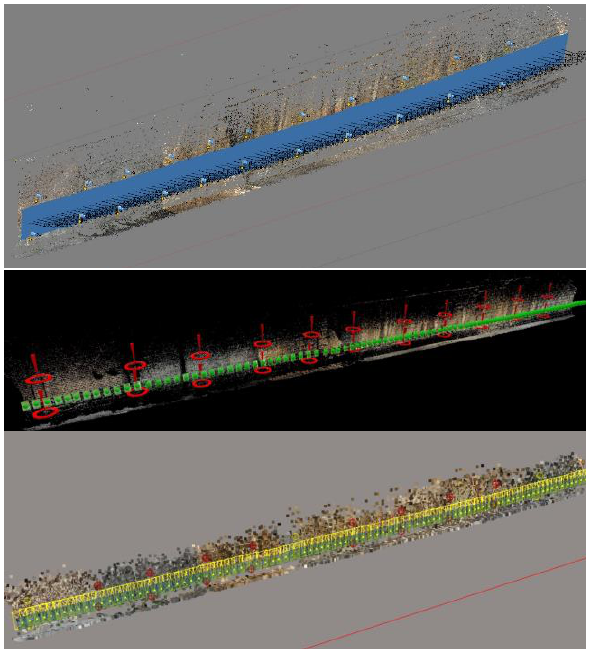
Figure 3. Camera poses and 3D points estimated with the different software.